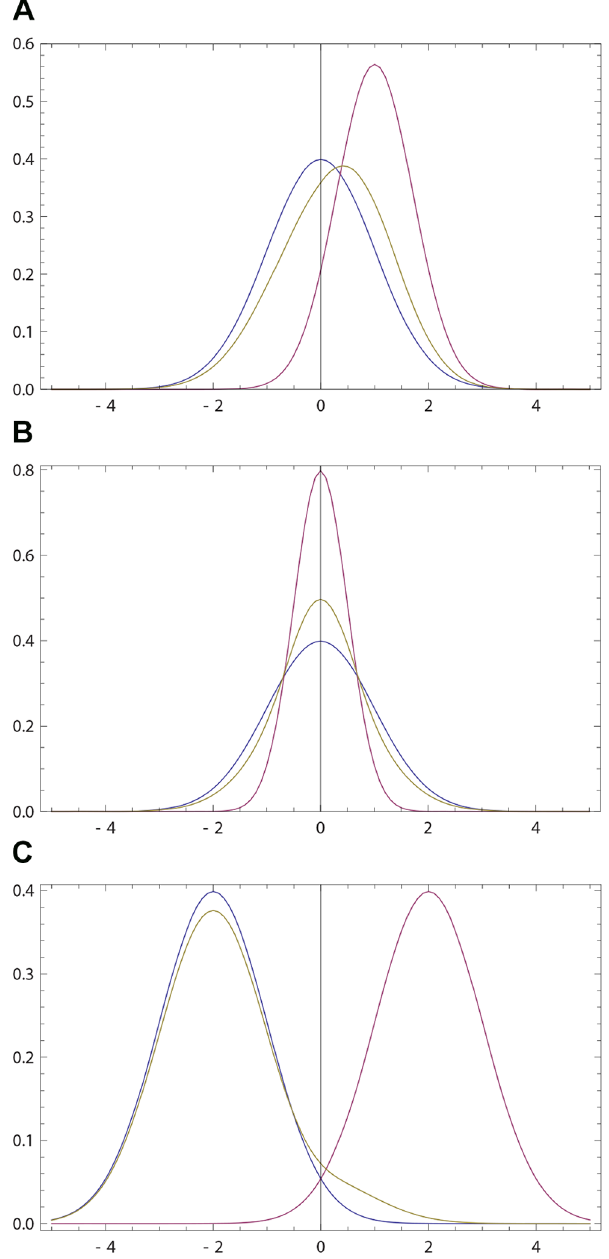
Figure 1. Opinions described via Gaussian densities (17) . The initial opinion of P is described by Gaussian probability density p ( x ) (blue curve) centered at zero; see (17). The opinion of Q amounts to Gaussian probability density q ( x ) (purple curve) centered at a positive value. For all three figures continuous density f ( x ) ( f ~ p , q , ~ pp ) were , x k z 1 { x k ~ 0 : 1 . The resulting approximated by 100 points f f ( x k ) g 100 k ~ 1 opinion ~ pp ( x ) of P is given by (16) with E ~ 0 : 5 (olive curve). (a)